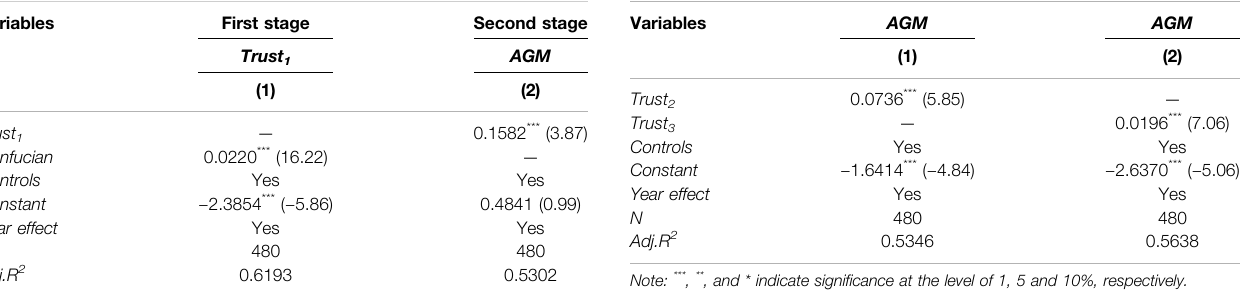
TABLE 6 | Robustness checks of two-stage least squares (2SLS). TABLE 7 | Robustness checks using alternative measures of social